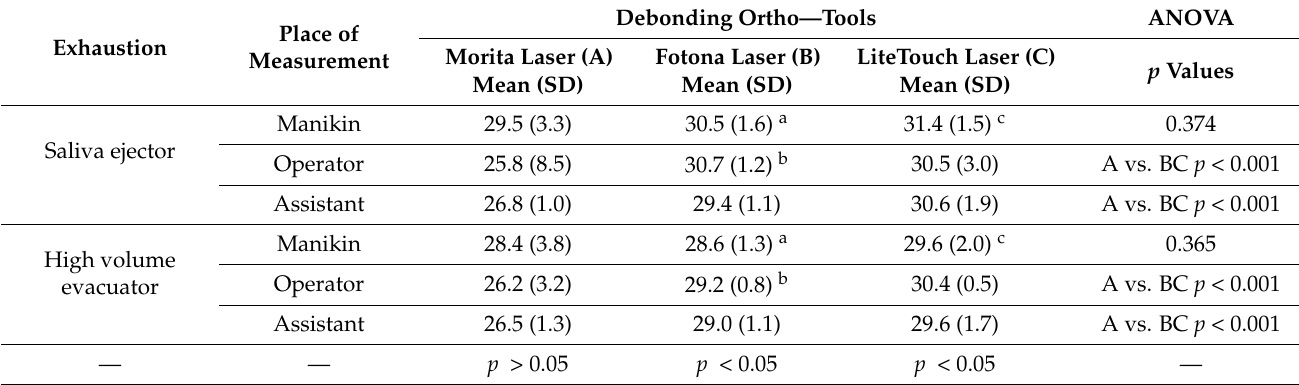
Table 4. The level of aerosol particles ( × 103) measured at manikin, operator, and assistant mouths (Mean (SD)) during orthodontic bracket debonding. Similar small letters in a column indicate statistical significance between suction tools assessed at the same measured level (operator, assistant, or manikin).